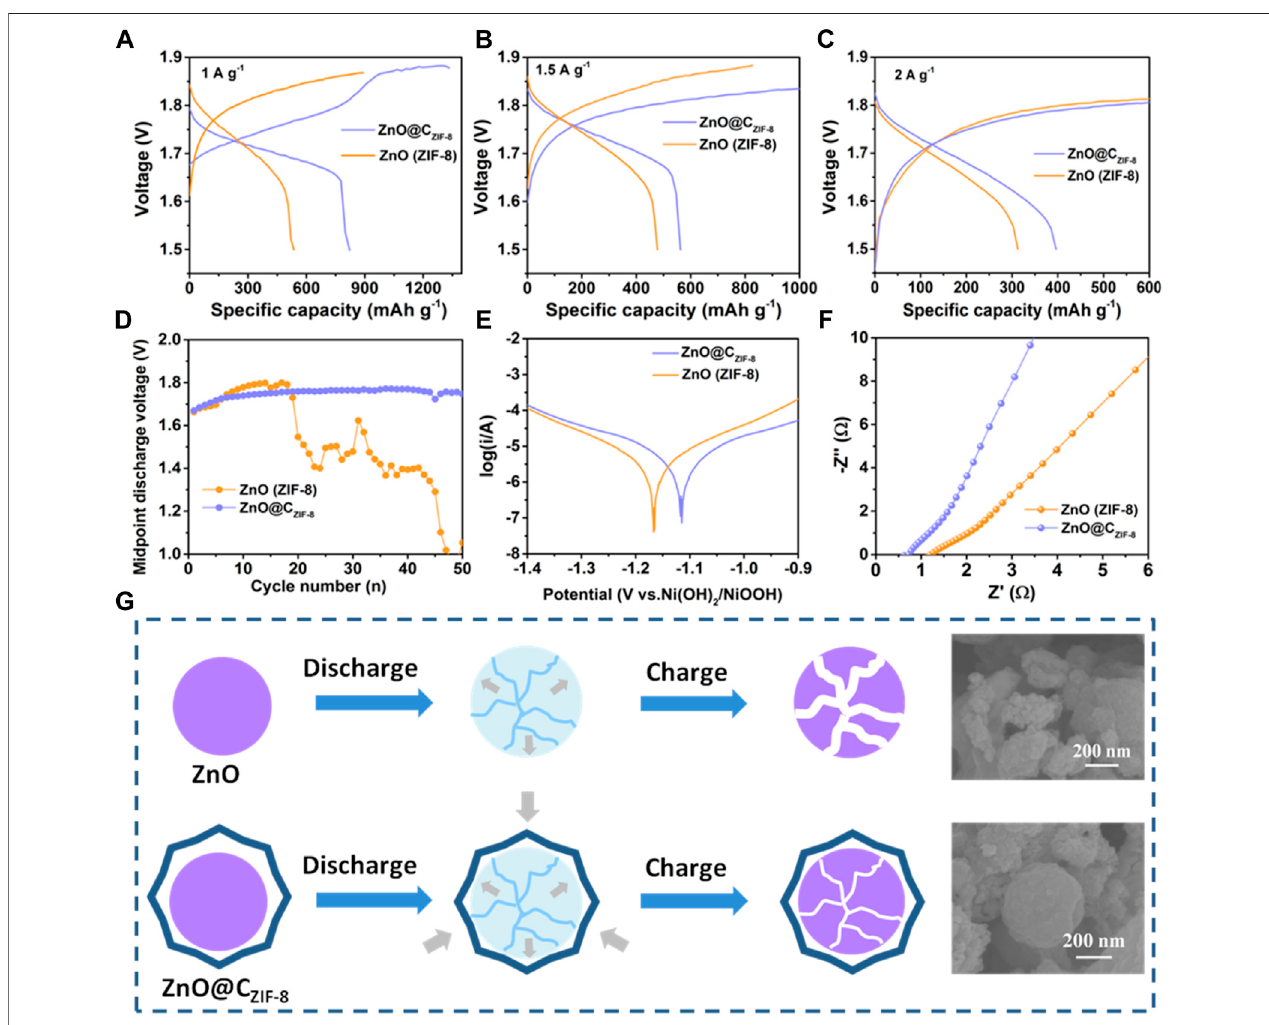
FIGURE 6 | Rate performance of ZnO (ZIF-8) and ZnO@C ZIF-8 electrodes at different current densities: (A) 1 A g − 1 , (B) 1.5 A g − 1 , and (C) 2 A g − 1 . (D) Midpoint discharge voltage curves of the Ni-Zn batteries with different anodes of ZnO (ZIF-8) and ZnO@C ZIF-8 . (E) The Tafel plot of ZnO (ZIF-8) and ZnO@C ZIF-8 electrodes. (F) Nyquist plots of ZnO (ZIF-8) and ZnO@C ZIF-8 electrodes. (G) Morphological changes after the charge/discharge processes.